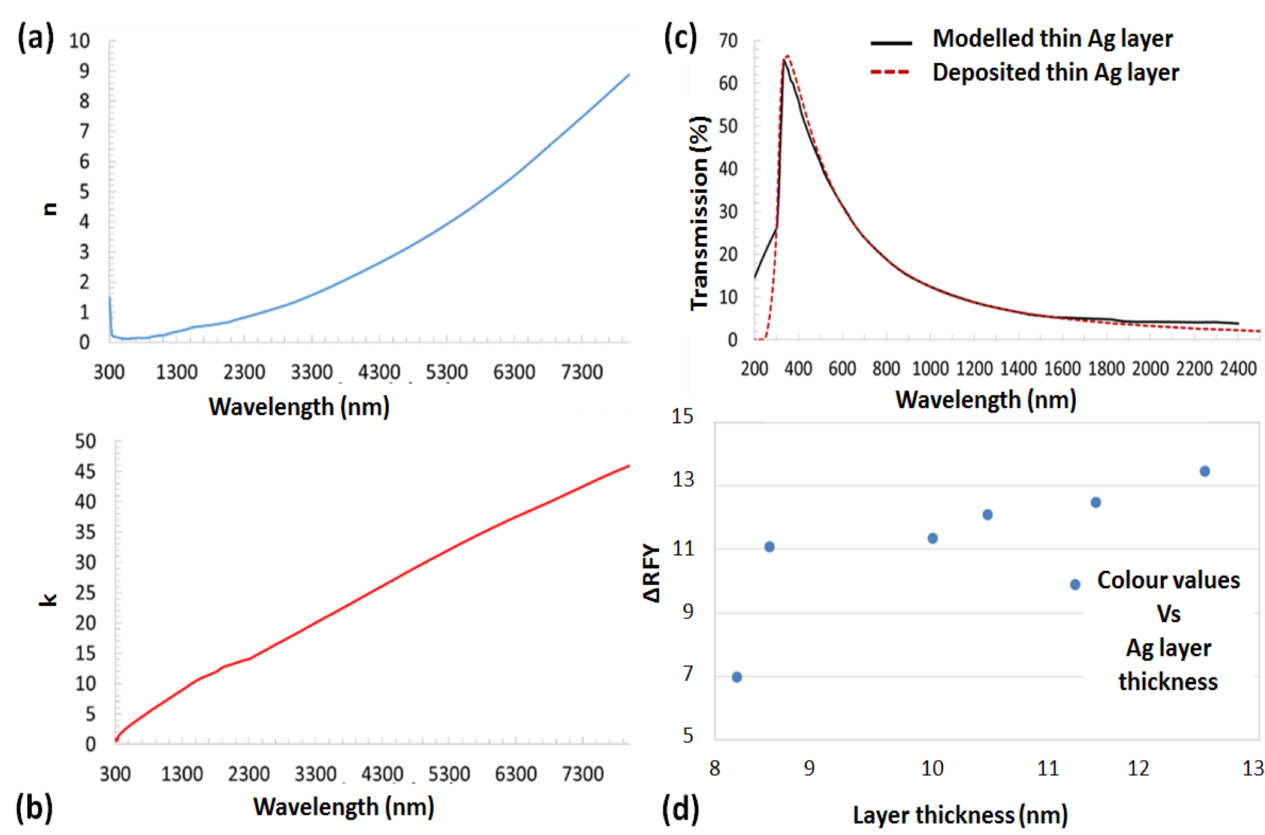
Figure 2. Extrapolated digitized optical constants dispersion data ( a , b ), and the optical ( c ) [32], and color ( d ) characteri- zation results for thin sputtered Ag layers. The color values (measured using Minolta 508D) for different Ag thicknesses show the variation in ∆ RFY versus Ag layer thickness, which reflects the importance of characterization for optimum film